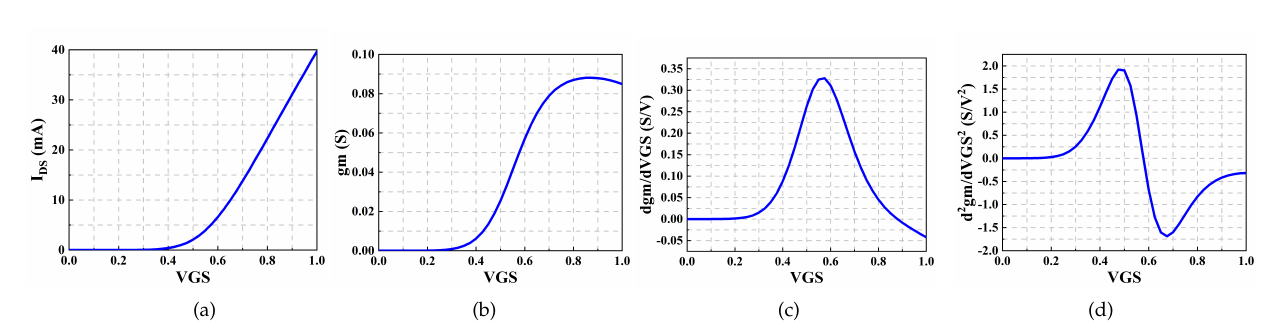
Figure 7. I DS and derivatives versus V GS 1 of main transistor M 1 . ( a ) I DS ; ( b ) g m 1 ; ( c ) g 2 ; ( d ) g 3 .